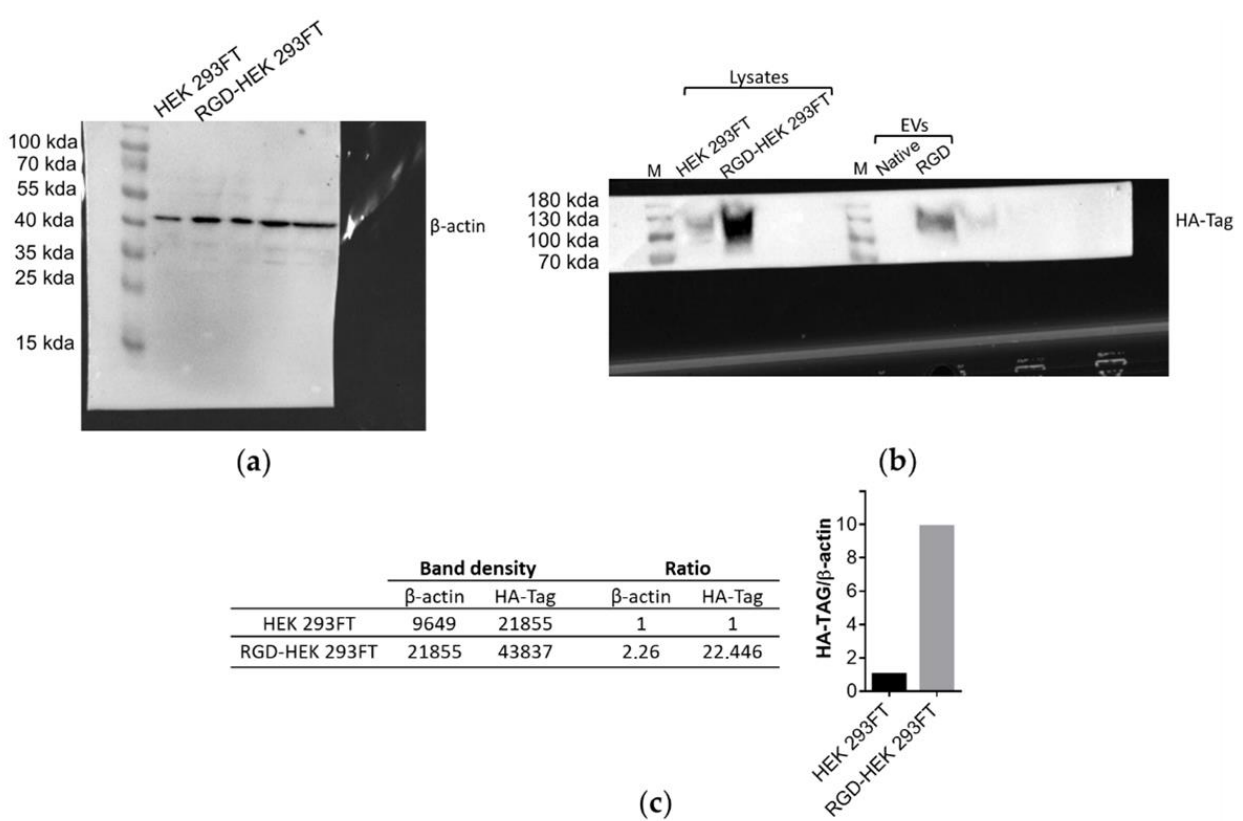
Figure A2. Raw blot images. ( a ) Blot image for HA-tag expression in cell lysates and EV samples. An overflow of RGD-HEK 293FT cell lysate sample from lane 3 to lane 2 can be seen, and slight spillage of RGD-EV sample can be seen from lane 3 to lane 4. ( b ) Blot image for b-actin expression in HEK 293FT and RGD-HEK 293FT cell lysate samples. ( c ) Densitometry analysis performed with ImageJ software for HEK 293FT and RGD-HEK 293FT cell lysates, normalised to b-actin. SY T O